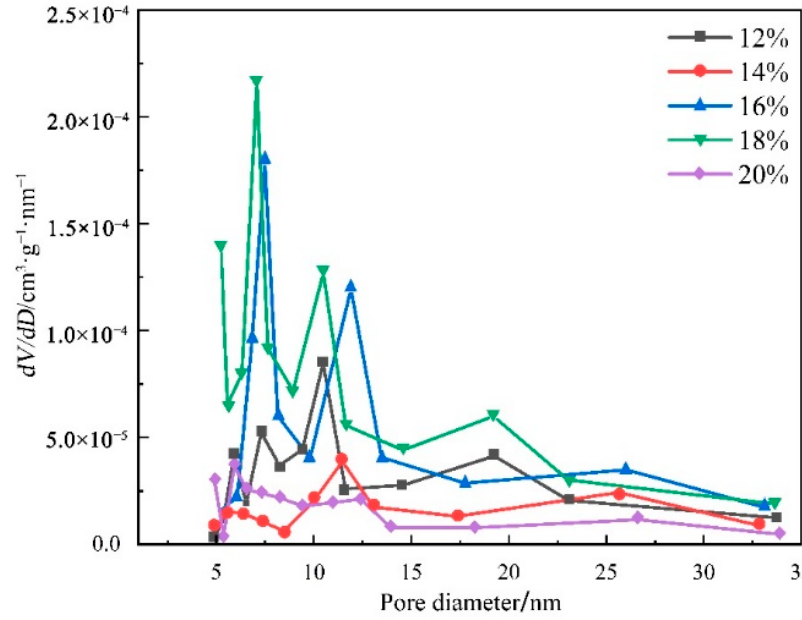
Figure 3. BET analysis of the electrospun fiber surface at different concentrations. Table 1. Specific surface area and average pore diameter of the composite nanofiber film.